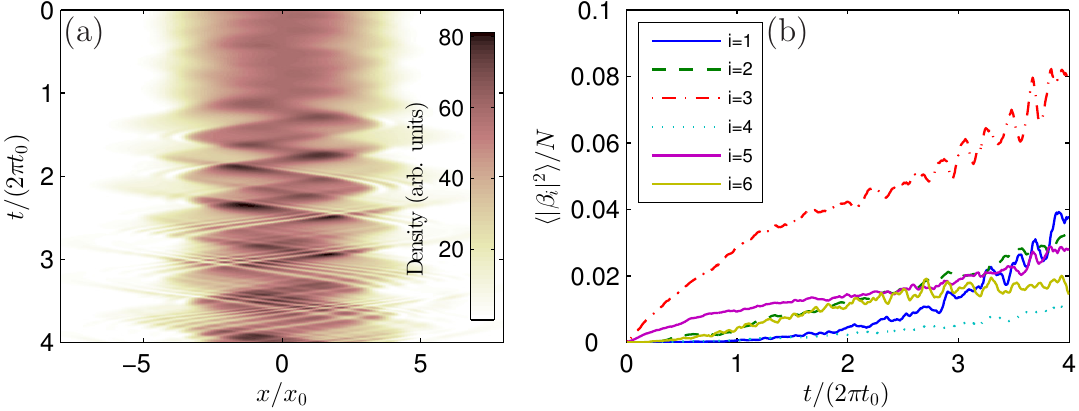
Figure 6. Response for a cavity wavelength of k = 1 . 03 x − 1 O of Equation (43) provides maximal coupling to the third Bogoliubov mode. ( a ) Density 3 of the stochastic field | ψ ( x, t ) | 2 for a single stochastic realization of a measurement record. ( b ) Average single trajectory Bogoliubov mode populations, averaged over 400 realizations. Subfigure ( b ) reproduced from